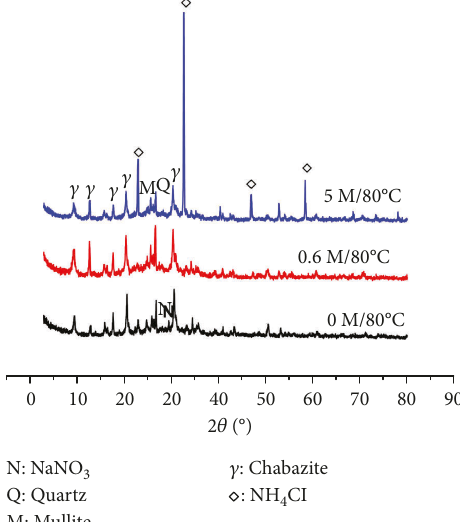
Figure 2: XRD patterns of fly ash/cement waste forms of simulated LILRW after leaching in different concentrations of NH 4 Cl at 80 ° C.